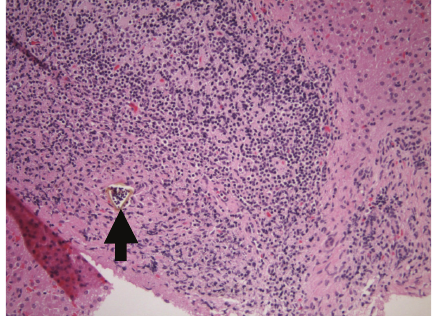
Figure 6: Microscopic section of lung from KMS389. Nematode larvae are present within regions of parenchymal destruction and fibrosis.